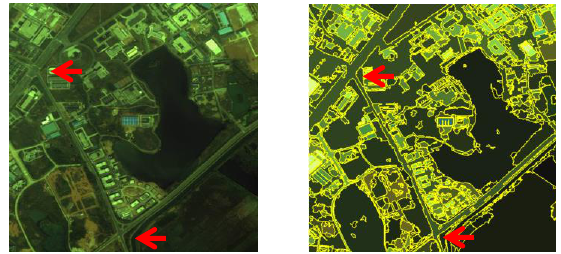
Figure 4. Image segmentation with mean shift